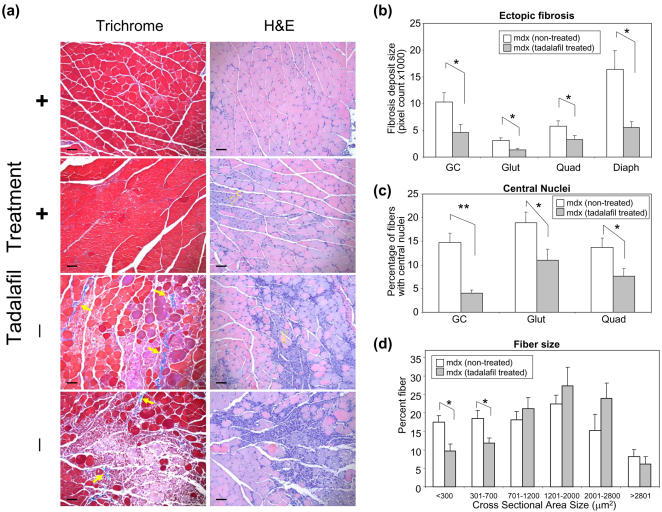
Evaluation of the efficacy of tadalafil by conventional histology.(a) Two images from different animals in tadalafil-treated and non-treated groups are presented for trichrome staining of gastrocnemius muscles (left panels): Ectopic fibrosis in extensively damaged areas was observed in the non-treated group (−) (yellow arrows). In the treatment group (+), there are still damaged fibers and ectopic fibrosis observed, but not to the level seen in the non-treated group. In H&E staining of gastrocnemius muscles (right panels), non-treated mdx mice showed many basophilic (purple) small cells reminiscent of infiltrating cells, proliferating fibroblasts/myoblasts, and tadalafil-treated group showed less. Myofibers with central nuclei, suggestive of regenerating fibers, are basophilic and prominent in the non-treated group, but were also observed in the treated group. Heterogeneity of fiber size was more prominent in the non-treated group. Yellow diamond arrows with “C” point to myofibers with central nuclei. Black scale bars on each micrograph image represent 50 µm. (b) The area size for ectopic fibrosis with blue staining was calculated in pixel size (n = 6 and 5 for non-treatment and tadalafil treatment groups). Tadalafil significantly reduced the amount of fibrosis in gastrocnemius (GC), gluteus (Glut), quadriceps (Quad), and diaphragm (Diaph) muscles (*: p<0.05 by t-test). (c) The percentage of myofibers with central nuclei is shown in a histogram. Tadalafil treatment reduced the percentage of central nuclei (*:p<0.05, **:p<0.01 by t-test) (d) The variation in fiber size in gastrocnemius muscles was quantified and shown as percentage fiber distribution. In non-treated mdx mice, the fiber size was uneven ranging from small (<300 µm2) to large (>2800 µm2) cross sectional area. Tadalafil treatment reduced the variation by lowering the percentage of small myofibers (*: p<0.05 by t-test)